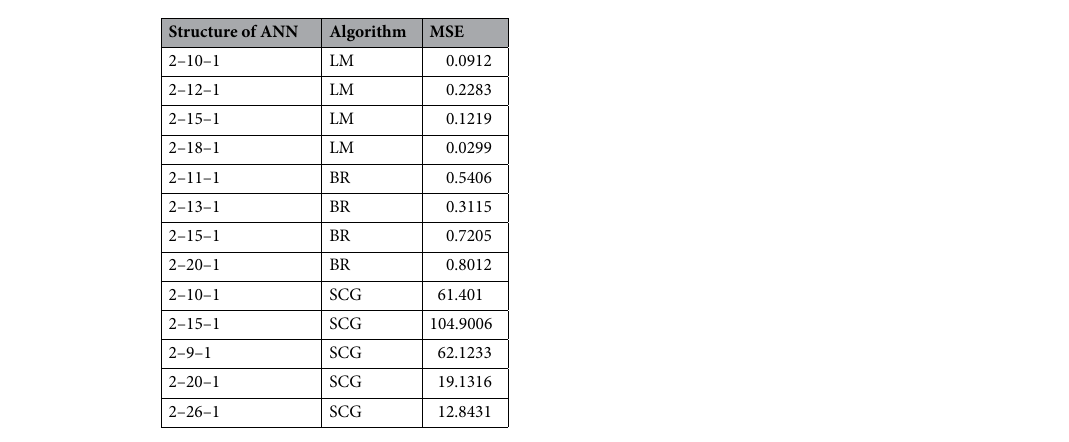
Table 4. MSE of architectures LM, SCG and resilient